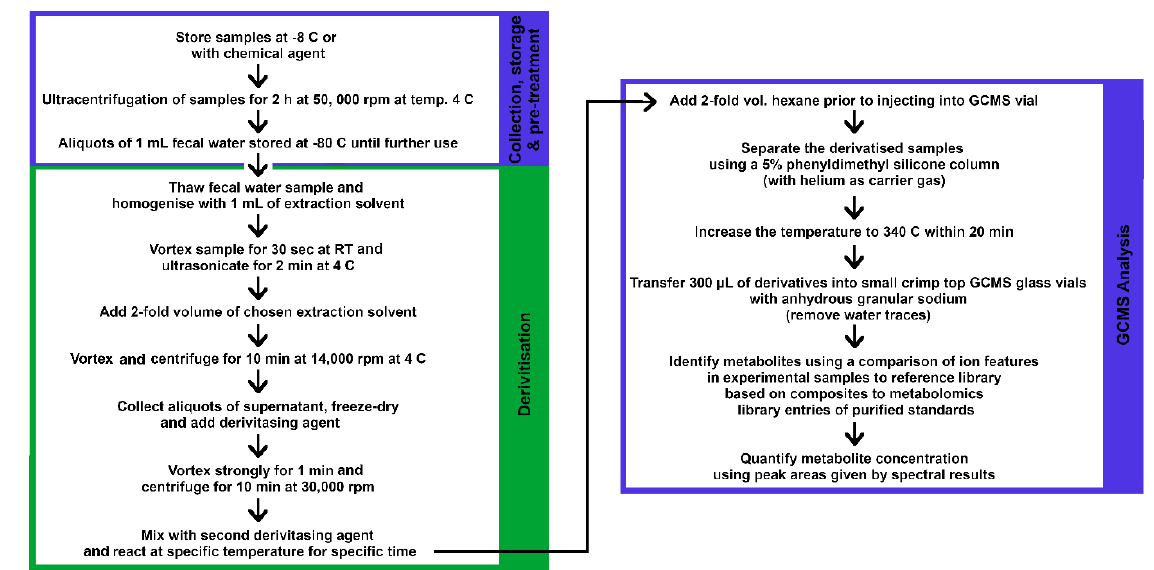
Figure 5. Summarized protocol for GC – MS analysis for human gut metabolites.